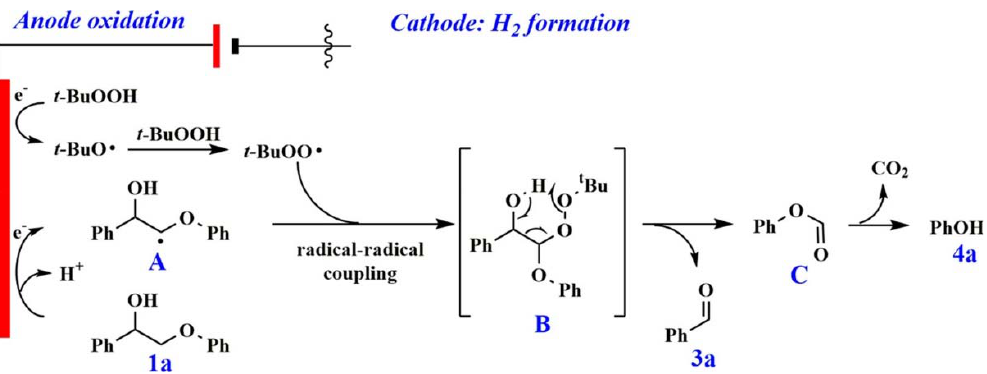
Figure 5. Mechanism of C α –C β bond cleavage in lignin model compounds. Reprinted with permis- sion from Ref. [109]. Copyright (2021) American Chemical Society.